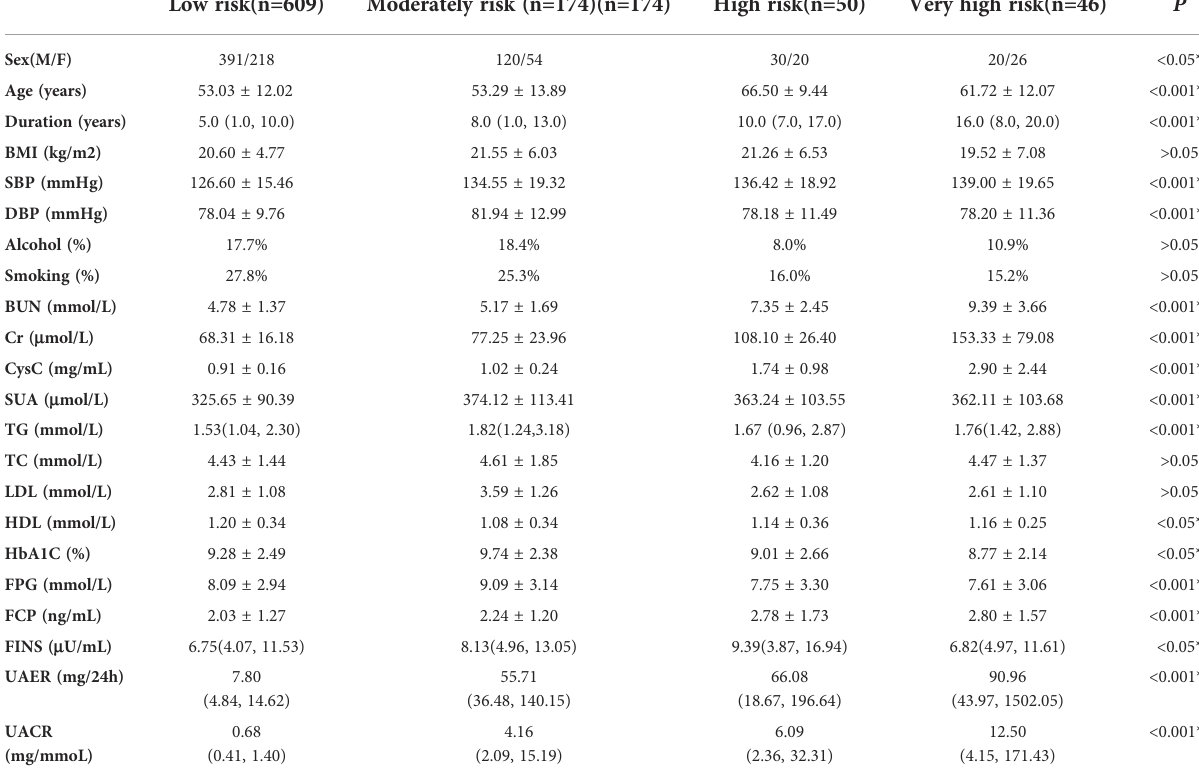
TABLE 1 Clinical characteristics of T2DM patients with different prognosis risk of